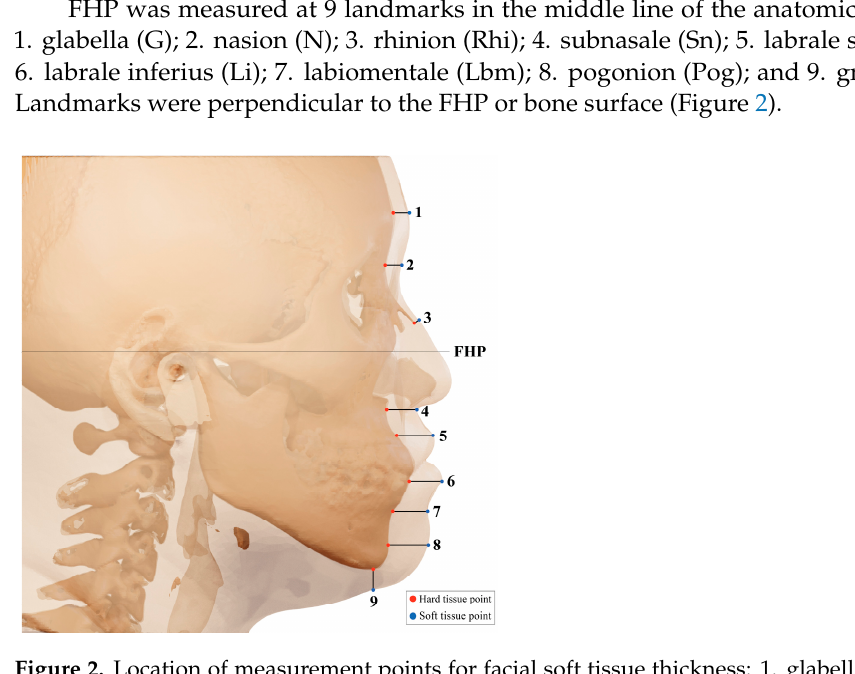
Figure 2. Location of measurement points for facial soft tissue thickness: 1. glabella; 2. nasion; 3. rhinion; 4. subnasale; 5. labrale superius; 6. labrale inferius; 7. labiomentale; 8. pogonion; 9. gnathion.